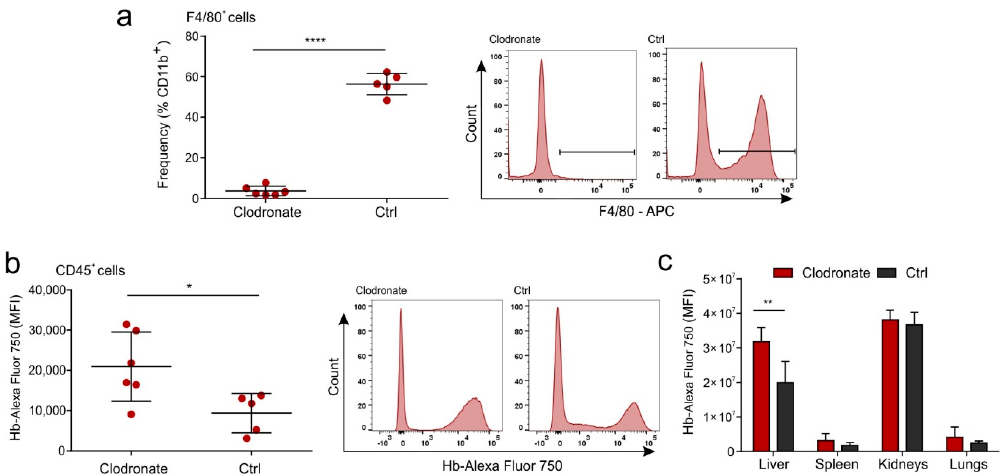
Figure 5. Hb is not scavenged by liver macrophages in a mouse model. Mice were depleted from macrophages by intravenous injection of liposomal clodronate 24 h before Hb administration. ( a , b ) Flow cytometry analysis of cells isolated from livers. ( a ) Frequency of F4/80 + cells in livers (shown as percentage of CD11b + cells) from mice treated with liposomal clodronate or PBS. Graph (left) and representative histograms (right). ( b ) Mean fluorescence (MFI) of Hb-Alexa Fluor 750 in liver CD45 + cells. Graph (left) and representative histograms (right). ( c ) Mean fluorescence (MFI) in the Hb-channel of entire organs collected 24 h after intravenous injection of 0.2 mg of Hb-Alexa Fluor 750 measured using MS FX PRO imaging system. Significance was calculated with t -test. * p < 0.05; ** p < 0.01; **** p < 0.0001.